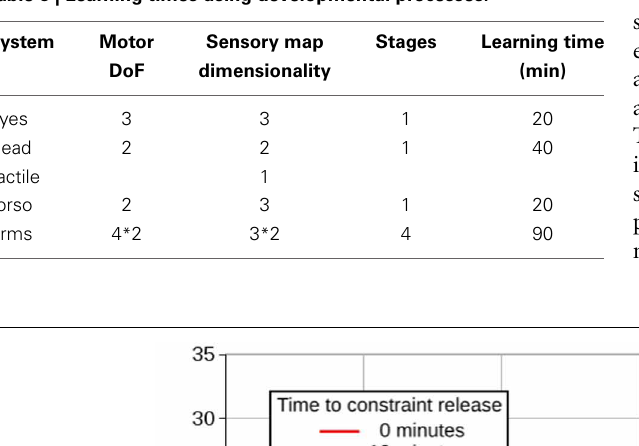
Table 8 | Learning times using developmental processes.